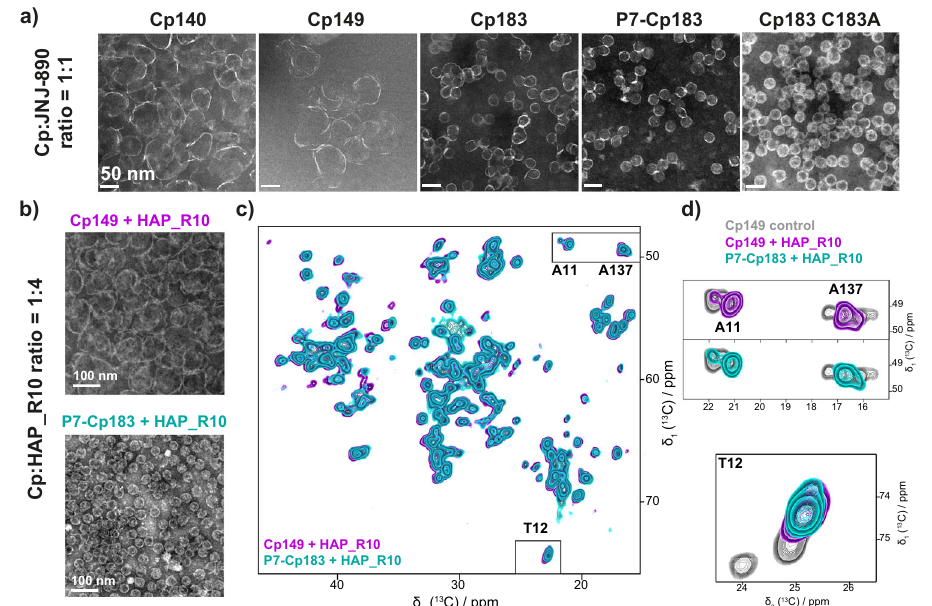
Fig. 3 | Effect of CAM-A at the mesoscopic and atomic level on truncated and full-length HBV core protein. a Negative-staining EM micrographs of different capsid constructs after incubation with 1-molar equivalent of the JNJ-890 CAM-A. Capsids made of truncated Cp149 result fully open, while those assembled from full-length Cp183 appear mostly closed. For EM micrographs at four different JNJ- 890ratiosseeSupplementaryFig.6. b EMmicrographscorrespondingtotheNMR